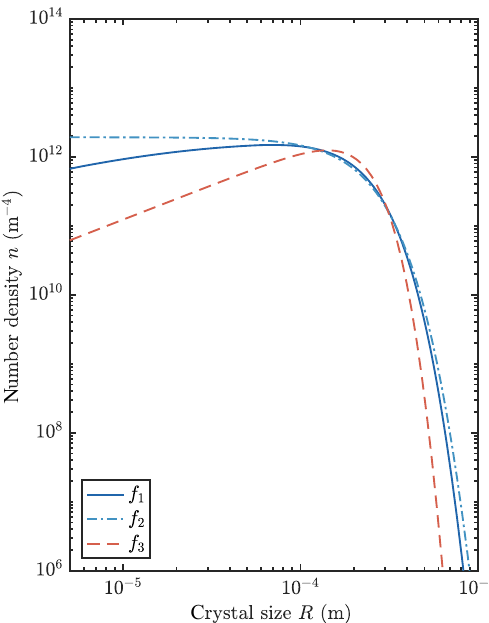
Figure 7. Evolution of (a) crystal concentration and (b) mixed-layer temperature using four different initial average crystal radii (0.05, 0.1, 0.2, and 0.4mm). Growth law f 2 and other parameters are as in Fig. 3.